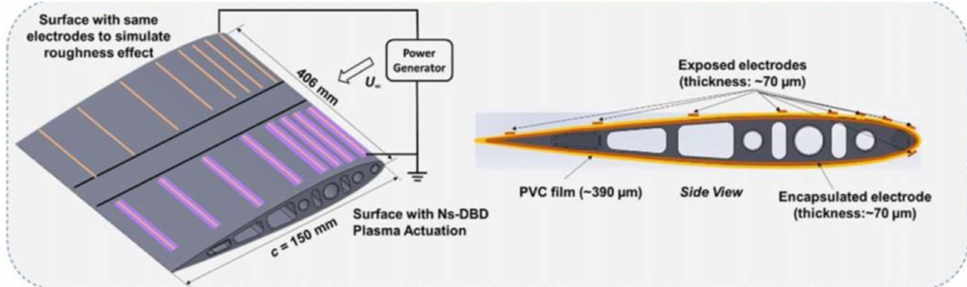
Figure 18. Schematic of the airfoil model used for anti-icing and deicing studies (adapted from Liu et al. (2019) based on [11] with the permission of IOP